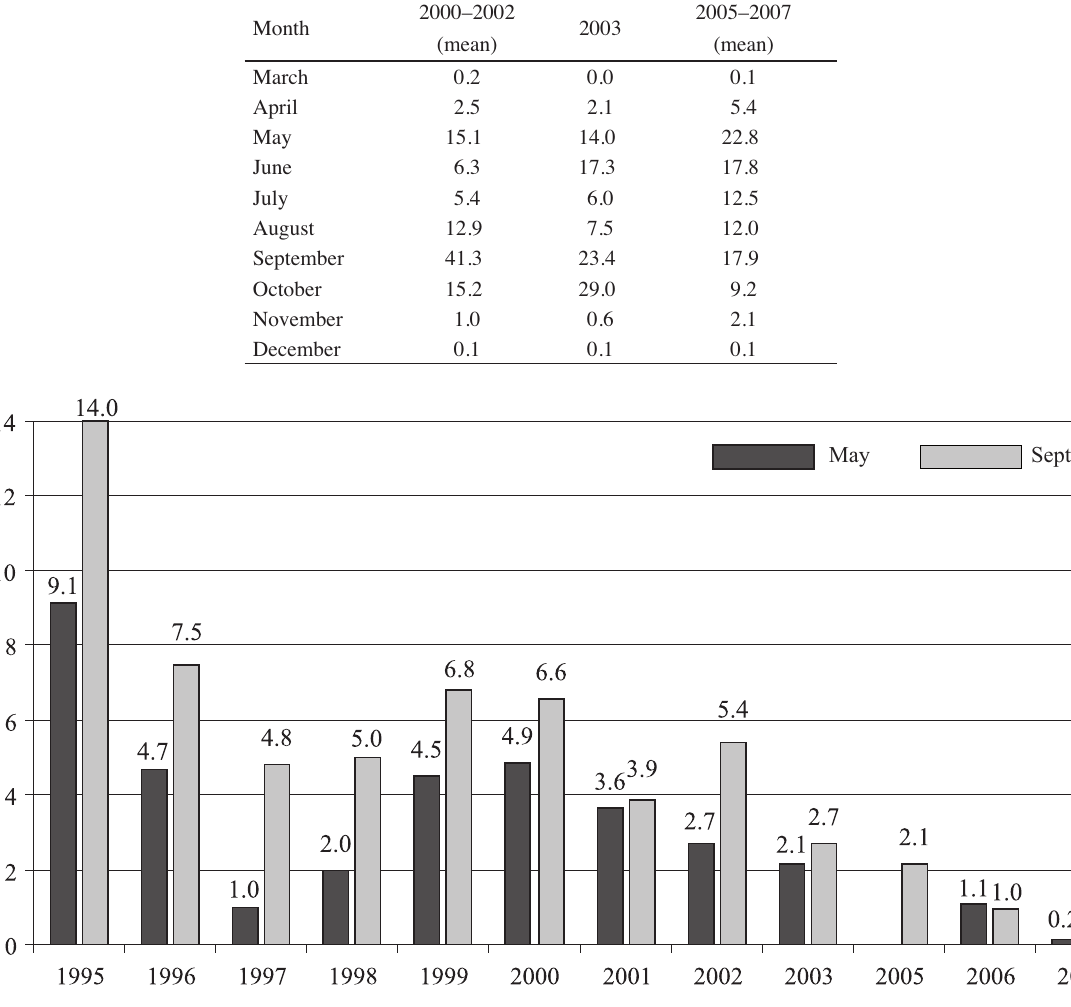
Fig. 5. Relative eel fishing efficiency in fyke net complexes in the border region in May and September